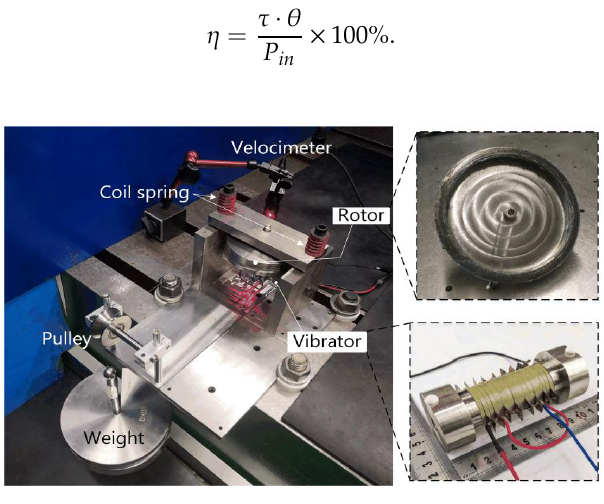
Figure 7. Experimental setup for measuring the load characteristics.